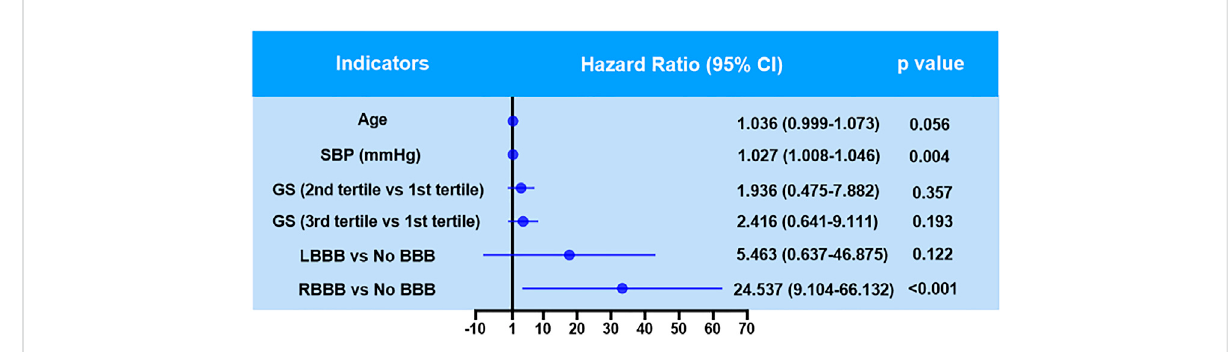
FIGURE 5 Hazard ratios for all-cause mortality in patients with new onset STEMI who underwent